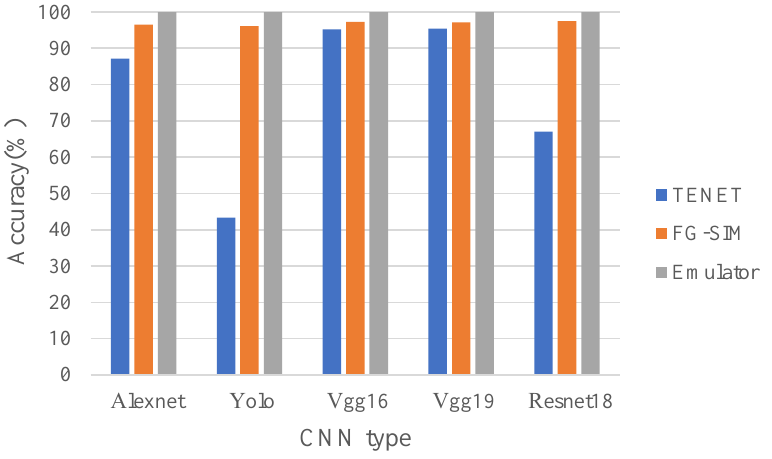
Figure 15. Comparison of TENET, FG-SIM and emulator under five convolutional